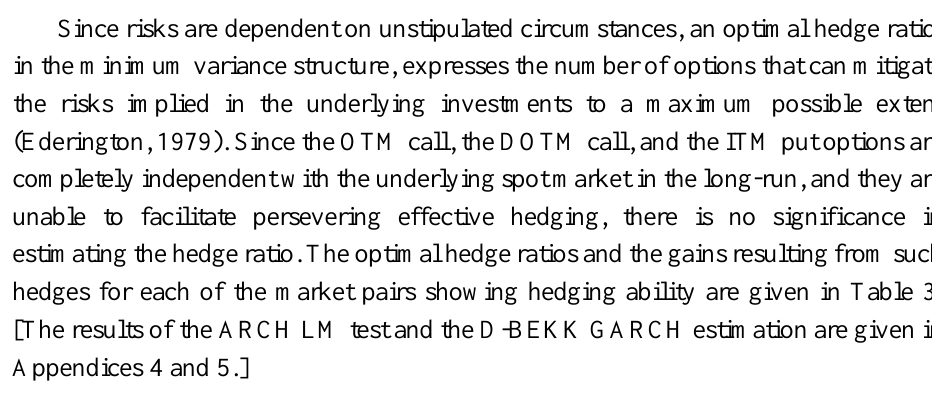
Table 3: Optimal Hedge Ratio and Hedging Gains Option